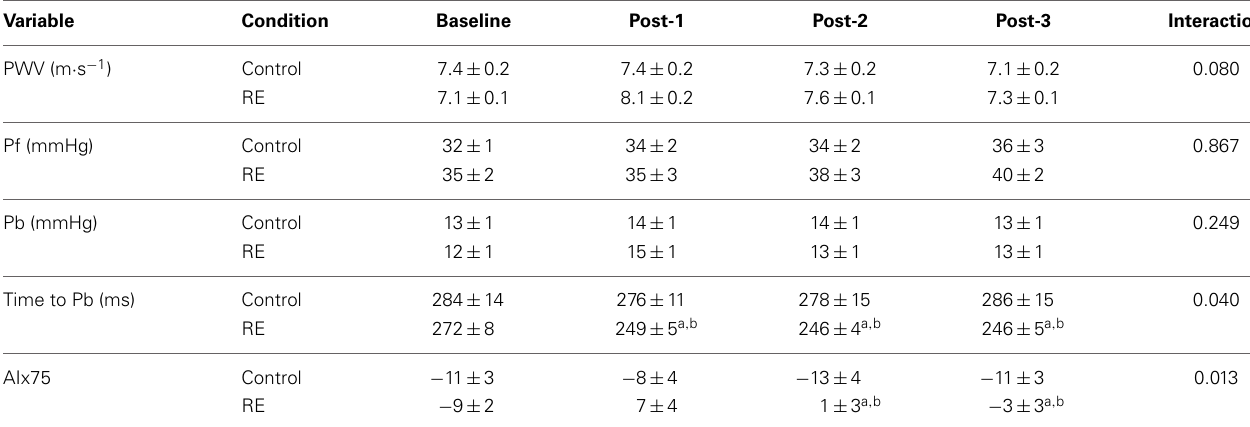
a significantly different from within-condition BL, p < 0.05.